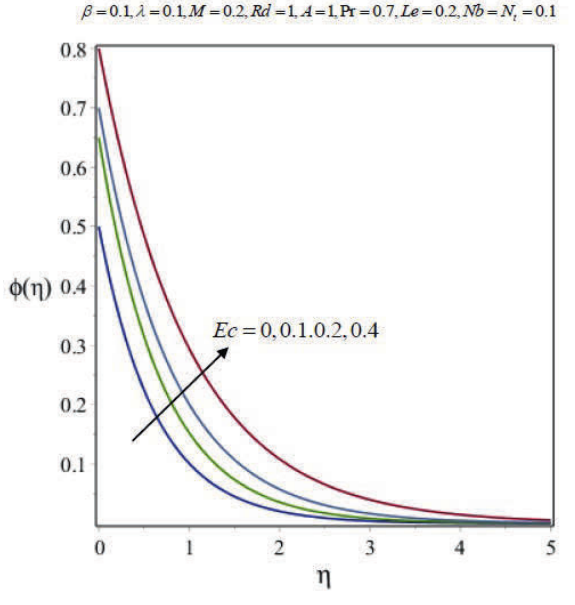
Fig. 22: Variation of nanoparticle concentration with η for several values of Eckert Number Ec